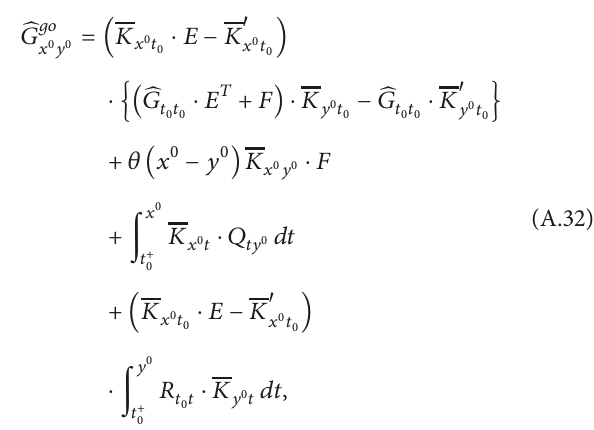
Figure 10: Two paths to obtain case 𝑥 0 < 𝑦 0